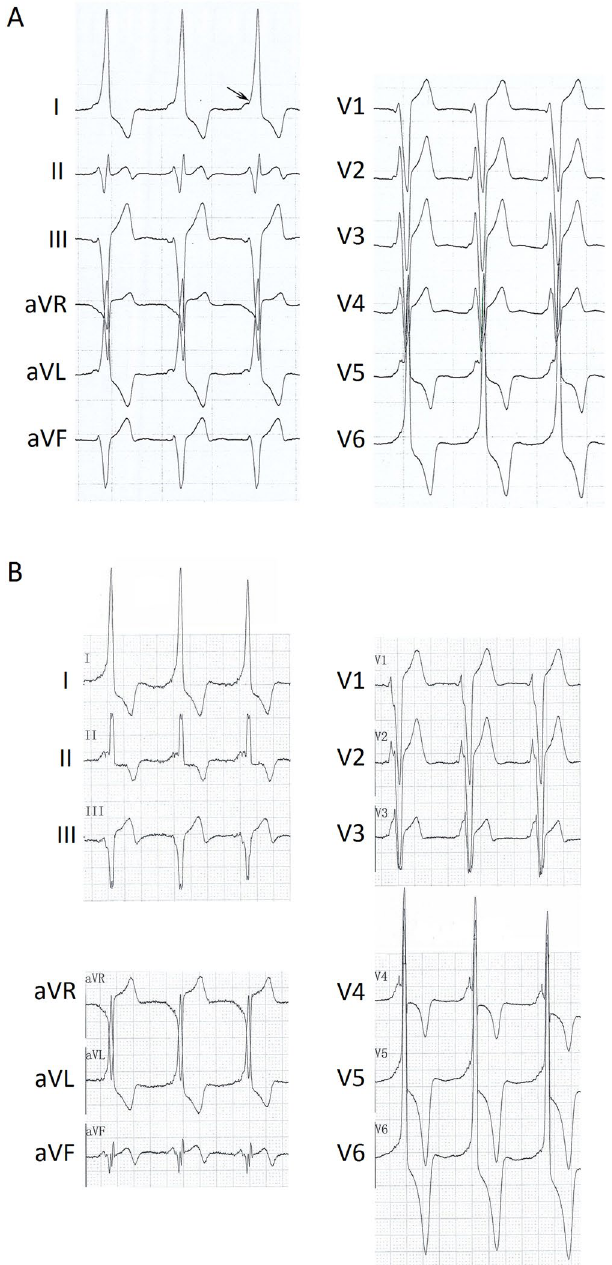
Figure 2. ECGs from the proband. ( A ) Resting ECG before ablation shows ventricular pre-excitation and delta waves (PR interval, 52 ms; QRS interval, 100 ms), with major QRS complex up waves of complexes in the V1 lead and major QRS complex down waves in V5–6 leads, indicative of a diagnosis of type B WPW syndrome. ( B ) Two years after ablation, short PR intervals (PR interval, 82 ms), enlarged ORS complexes (QRS interval, 190 ms), and deeply inverted T waves were detected in V5–6 leads. The arrow points to the delta